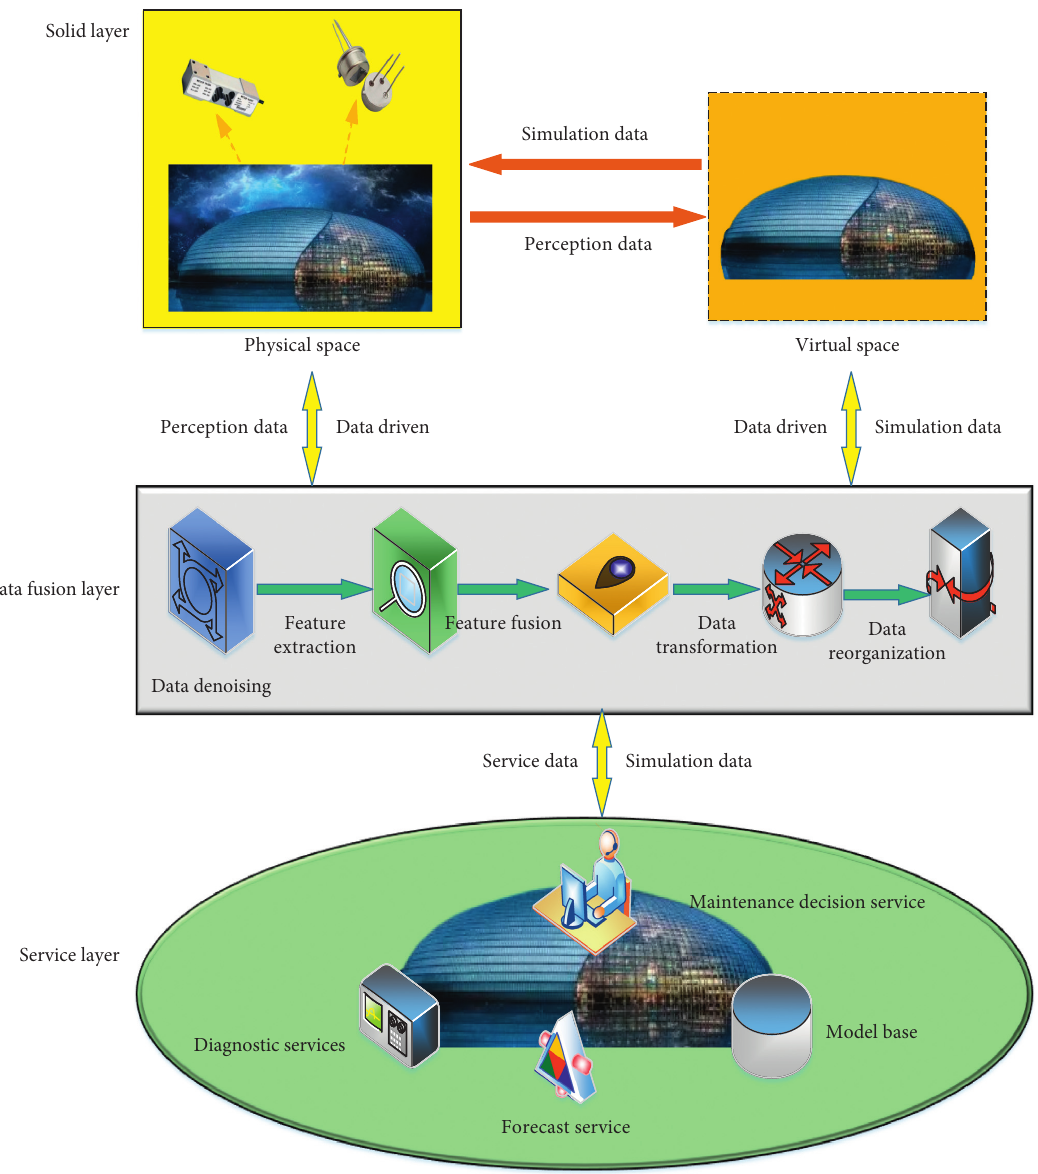
Figure 1: DTs application